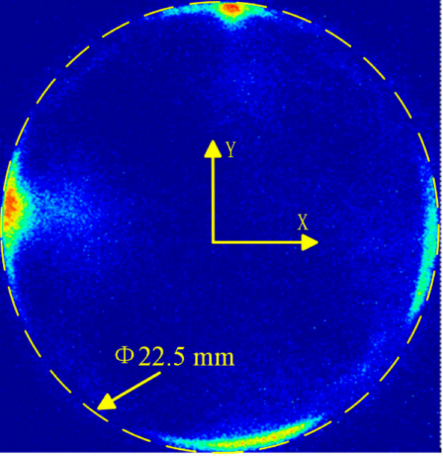
Figure 7. The distribution of the blue value at the diameter of 13 mm at the driving voltage of 190 V.